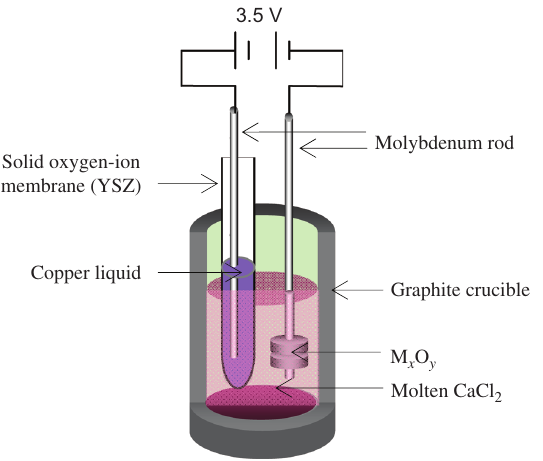
Figure 1: Schematic illustration of SOM experimental apparatus.